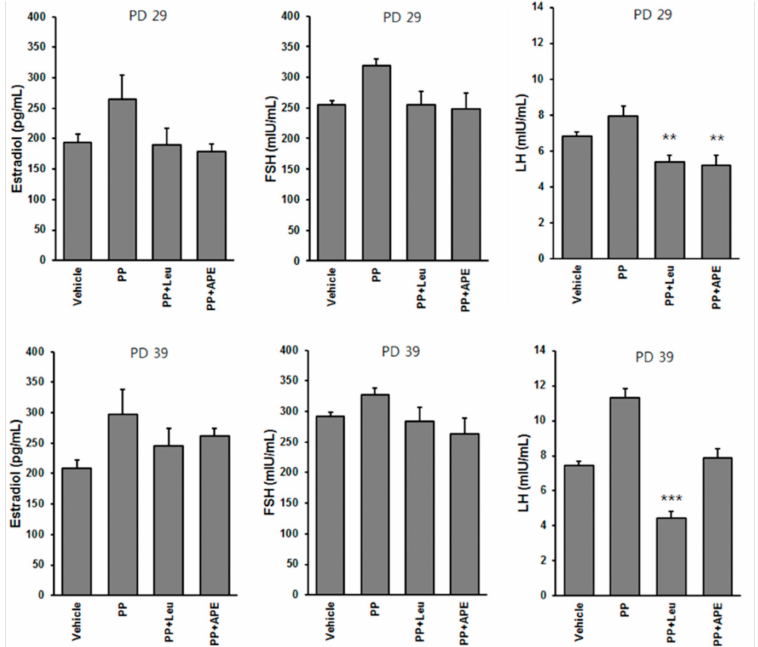
Figure 5. Effect of APE on serum gonadotropic hormone levels in experimental rats. ** p < 0.01; *** p < 0.001, compared to the PP